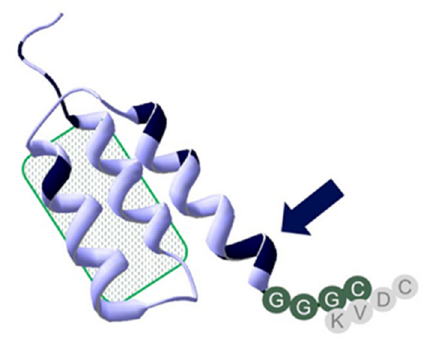
Figure 1. Overview of structural differences, features, and chelator positioning of ZHER2:41071, ZHER2:V2, and ZHER2:2395. All three constructs share the amino acid structure in the binding site, highlighted by the patch with a green pattern. Shared sequences are in a light blue structure, positions with scaffold variation are highlighted in black. The one close to the C-terminal chelator sequence GGGC (marked with an arrow) is consistent of an –SES- amino acids sequence, which replaced an -NDA-sequence to further improve peptide stability and increase hydrophilicity of the affibody molecule. The -SES- motif could have challenged efficient labeling by competing with the GGGC-chelator. Placement of a KVDC chelating sequence within ZHER2:2395 as compared to HER2:V2 and HER2:41071 is shown in gray.